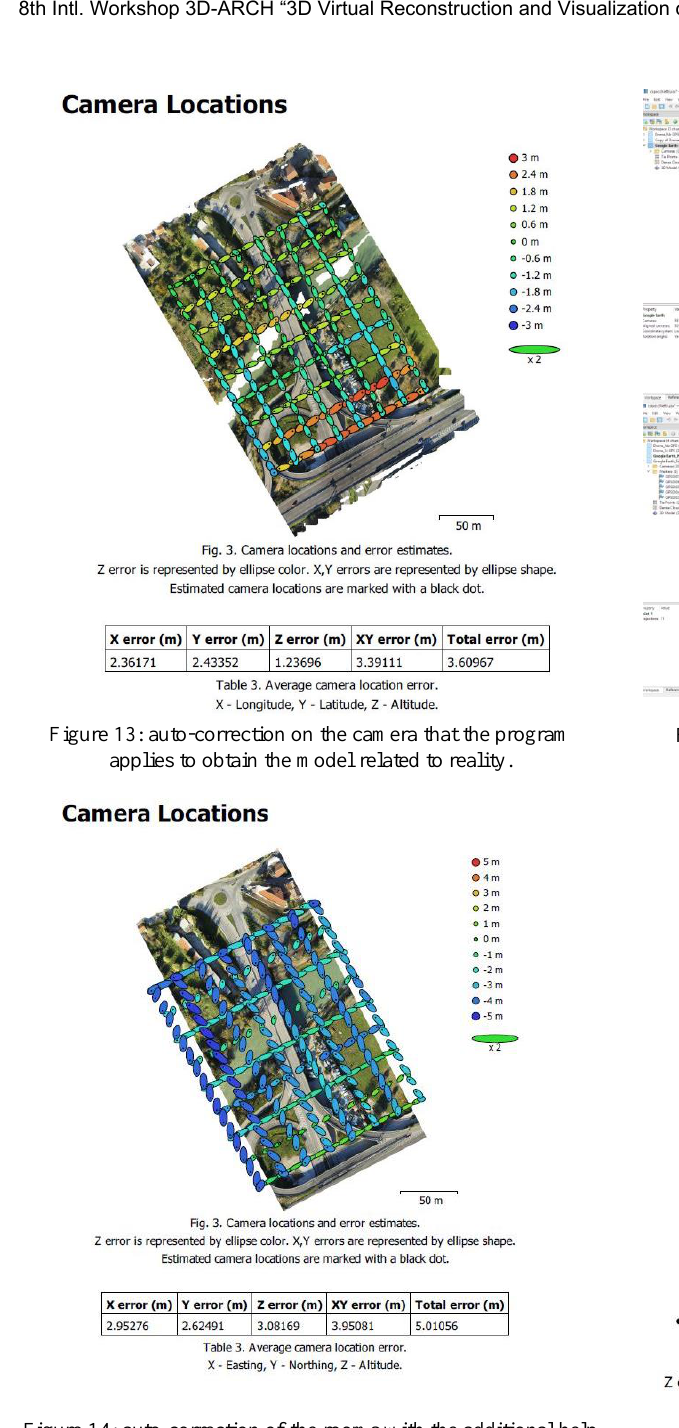
Figure 14: auto-correction of the rooms with the additional help of GPS points in order to have a valid camera alignment.